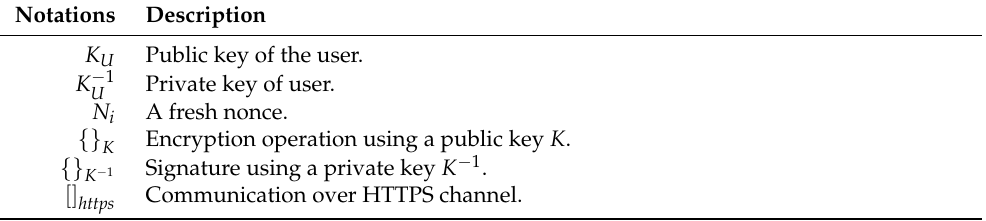
Table 1. Cryptographic notations.